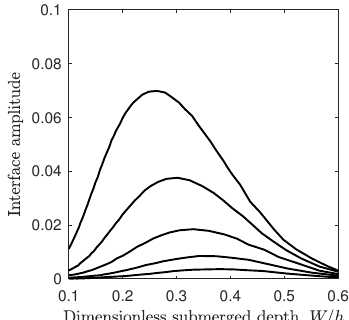
Figure 7. Force difference at the bottom of the obstacle versus dimensionless obstacle submerged depth. Each curve represents a different mud layer thickness with d / δ m = 0.5,1,1.5,2 (top to bottom). ∆ F = ( F − F ) / F = 0.5 s − 1 and all other parameters are the same as those mud solid solid . In all cases, ω used in Figure 6.